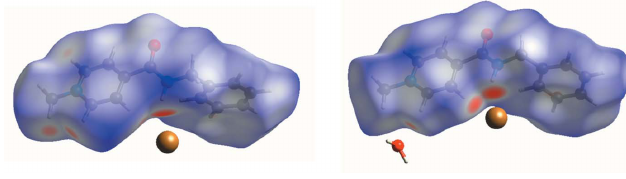
Figure 4 Hirshfeld surfaces mapped over d norm for cations A (left) and B (right) in the crystal structure of AmBr hemihydrate.